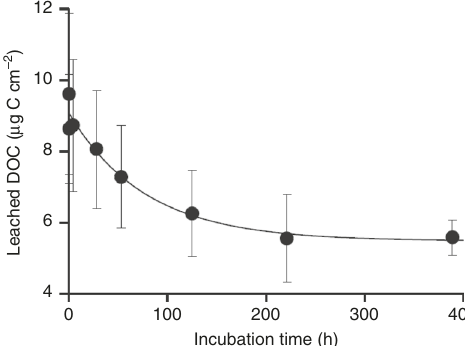
Fig. 1 Loss of DOC over time using LDPE. The original DOC concentration of the arti fi cial seawater before plastic addition was subtracted from all the points. Thus, the fi rst point represents the maximum leaching after the plastic addition. Error bars show the standard deviation of the mean of three replicates. First order rate constant = − 0.013 h − 1 ± 0.003; R 2 = 0.97; p < 0.001. LDPE low-density polyethylene, DOC dissolved LDPE and HDPE, either after 6 days or after 1 month of sterile